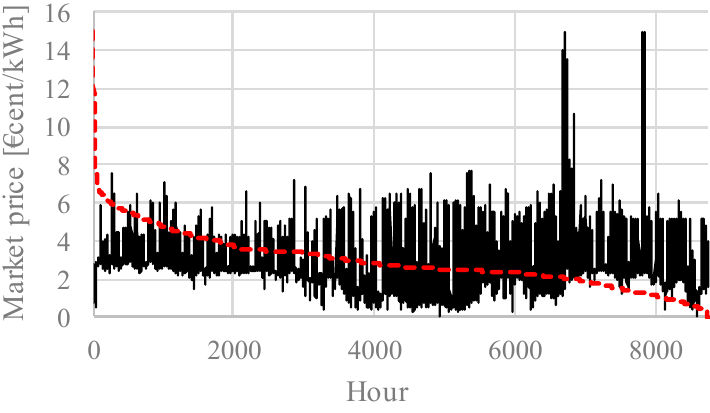
Figure 6. The hourly electricity market price for Finland, and its duration curve, in 2015.